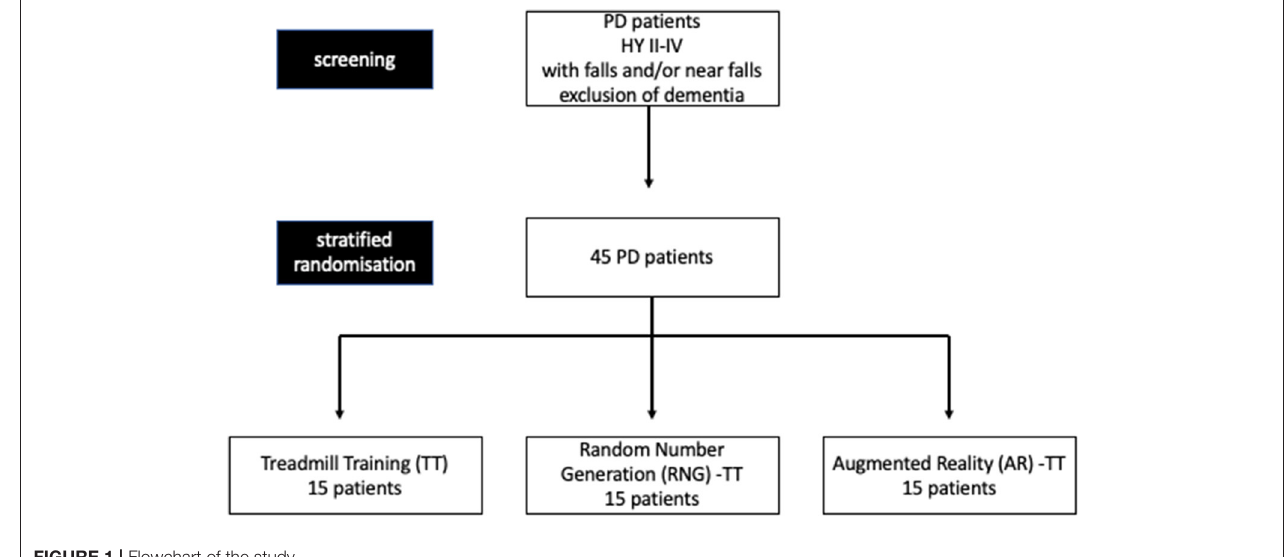
FIGURE 1 | Flowchart of the study.